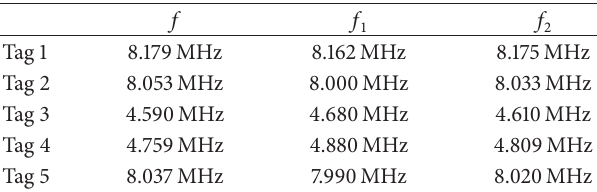
Table 1: The test result of resonant frequency.